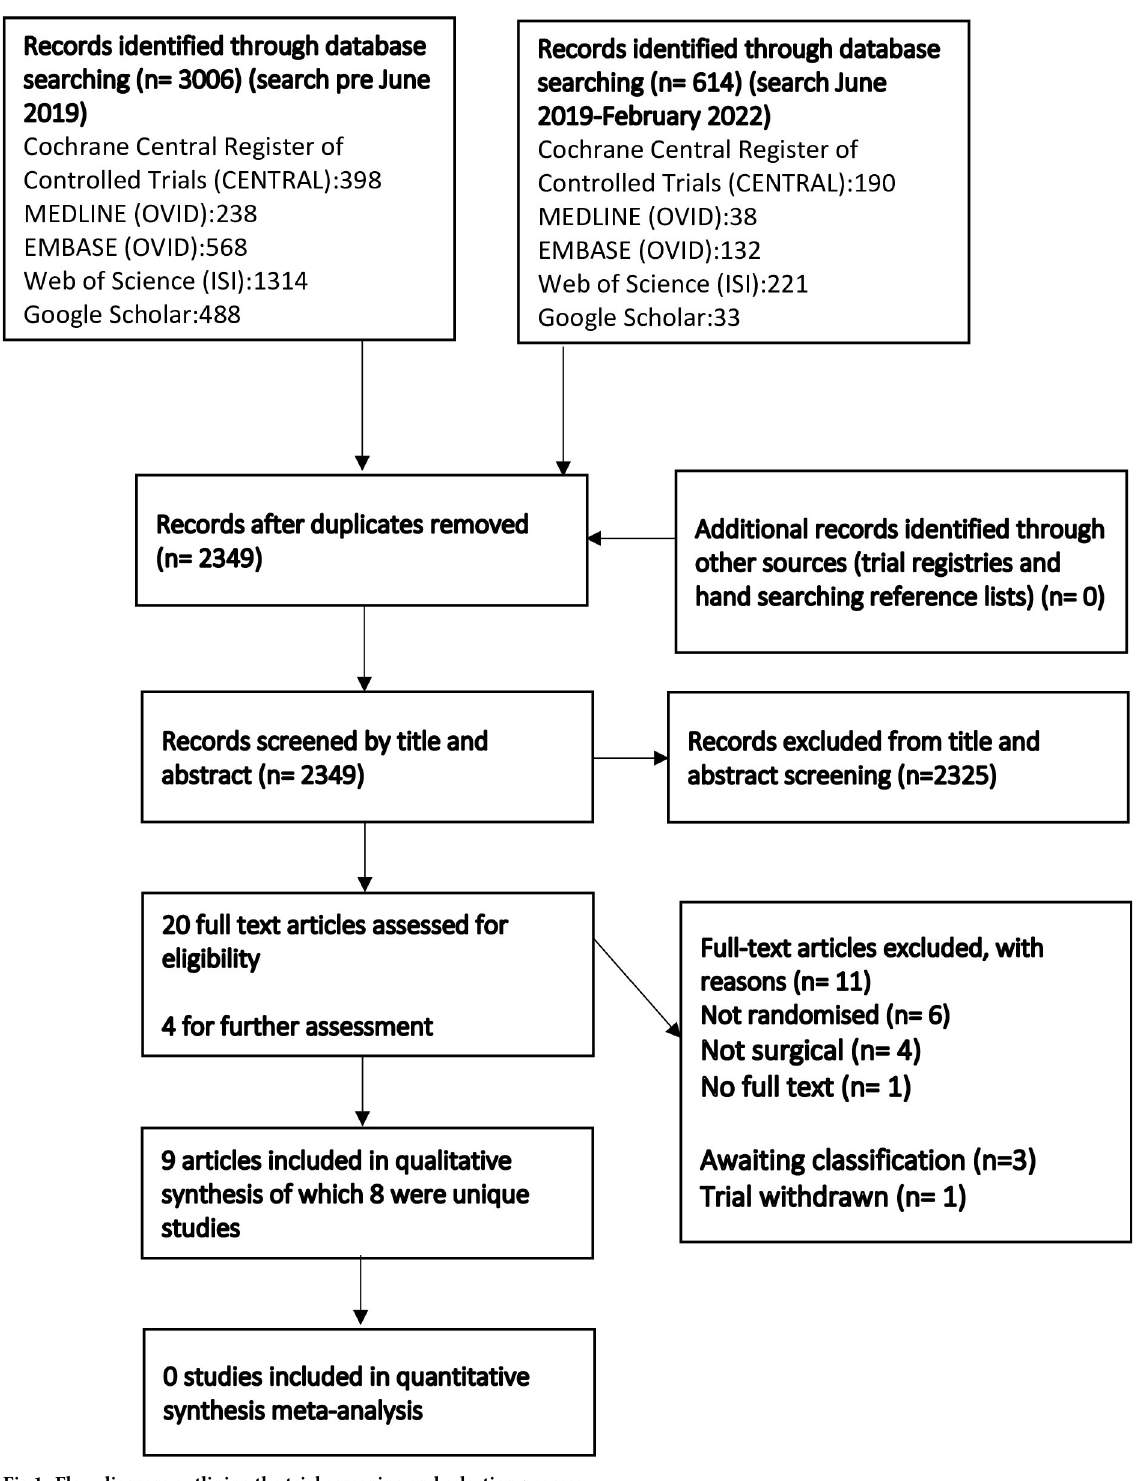
Fig 1. Flow diagram outlining the trial screening and selection process.